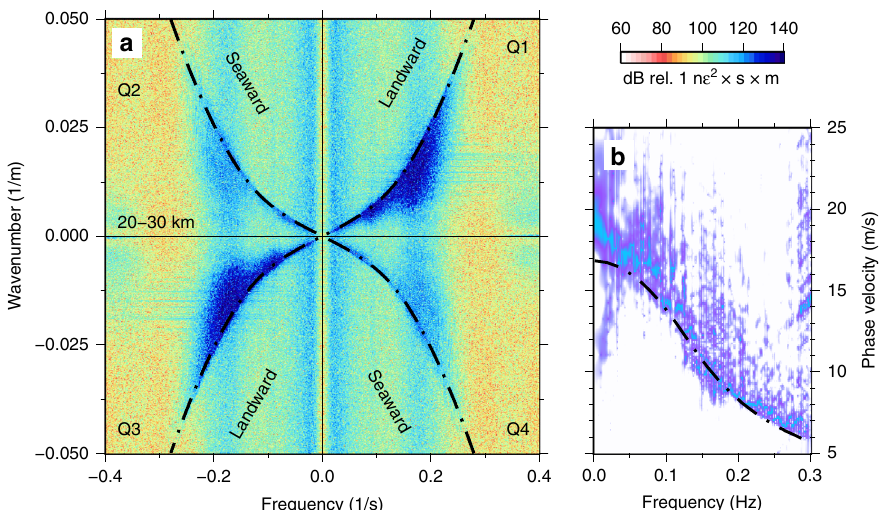
Fig. 4 Ocean surface gravity waves. a Raw distributed acoustic sensing frequency – wavenumber ( f - k ) spectrum calculated over 10 min between 20 and 30 km, showing strong landward-propagating and weak seaward-propagating ocean surface gravity waves. b The f - k spectrum from quadrant 1 of a projected into phase velocity space showing coherent dispersion from (cid:1) 17 m/s at small wavenumbers to (cid:1) 6 m/s at 0.3 Hz (each frequency bin is normalized). Both a and b are overlaid with the theoretical dispersion curve for ocean surface gravity waves, evaluated at a water depth of 25 m